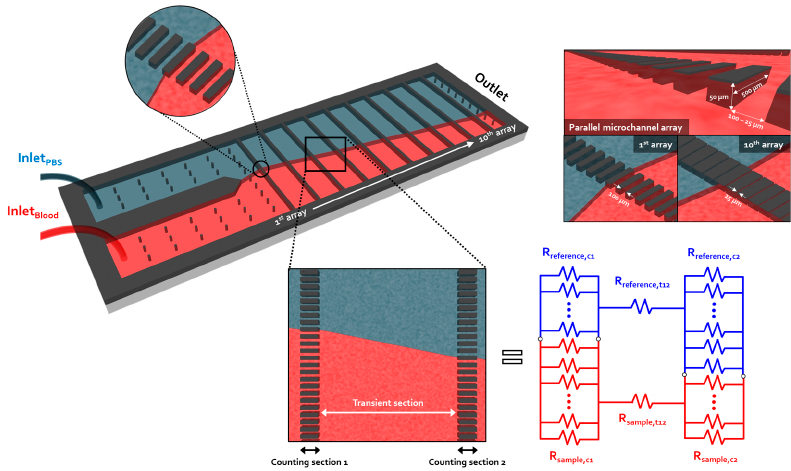
Figure 1. Schematic of the micro-viscometer. The micro-viscometer has a sequence of micro-channel arrays that generate 10 sets of shear rate. The viscosity is derived from the input flow rates for the reference sample fluids and the number of channels filled with both fluids. By varying the channel width at each array, different viscosity values can be obtained. For each array, 100 micro-channels are arranged in parallel. It is designed accordingly to change the width of the channel from the first array to the tenth array to enable each array to form a different shear rate from a single flow condition.